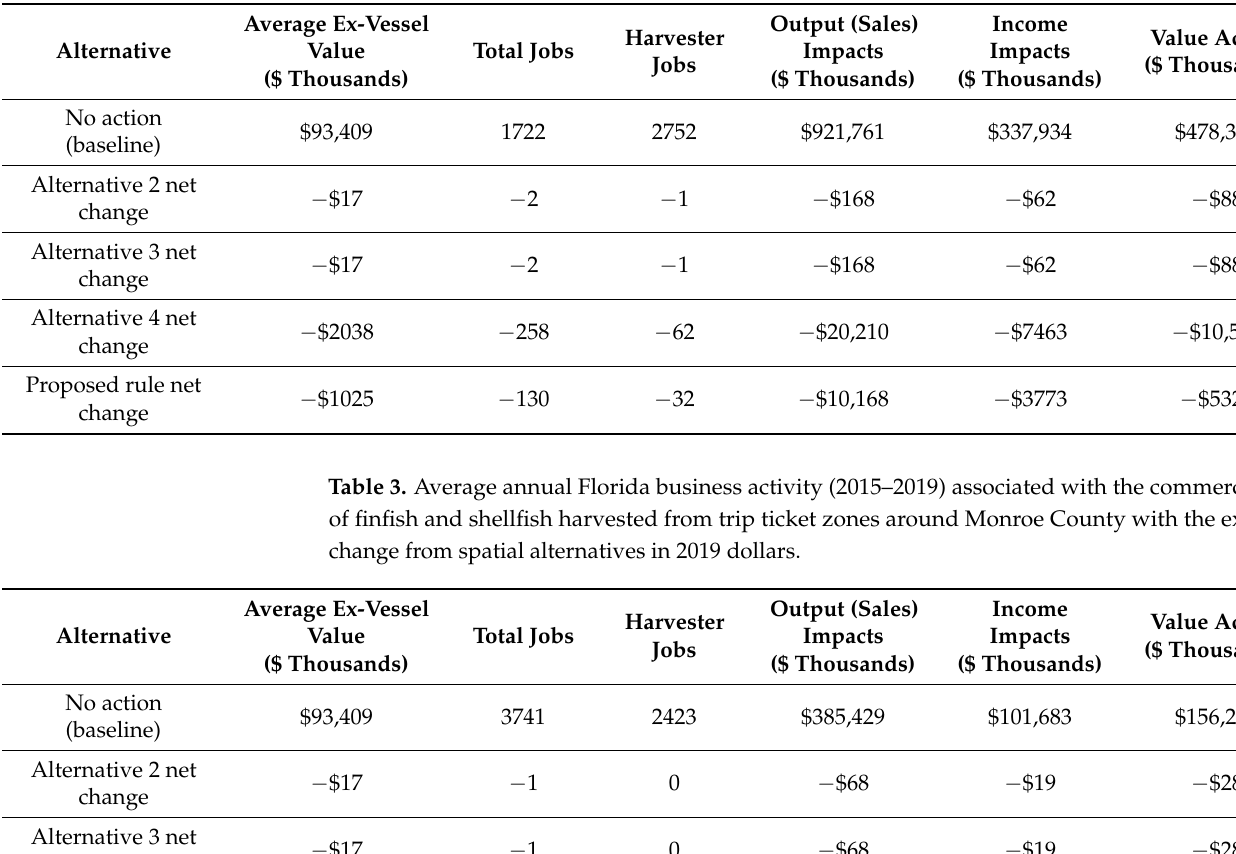
Table 2. Average annual U.S. business activity (2015–2019) associated with the commercial sale of finfish and shellfish harvested from trip ticket zones around Monroe County with the expected change from spatial alternatives in 2019 dollars.